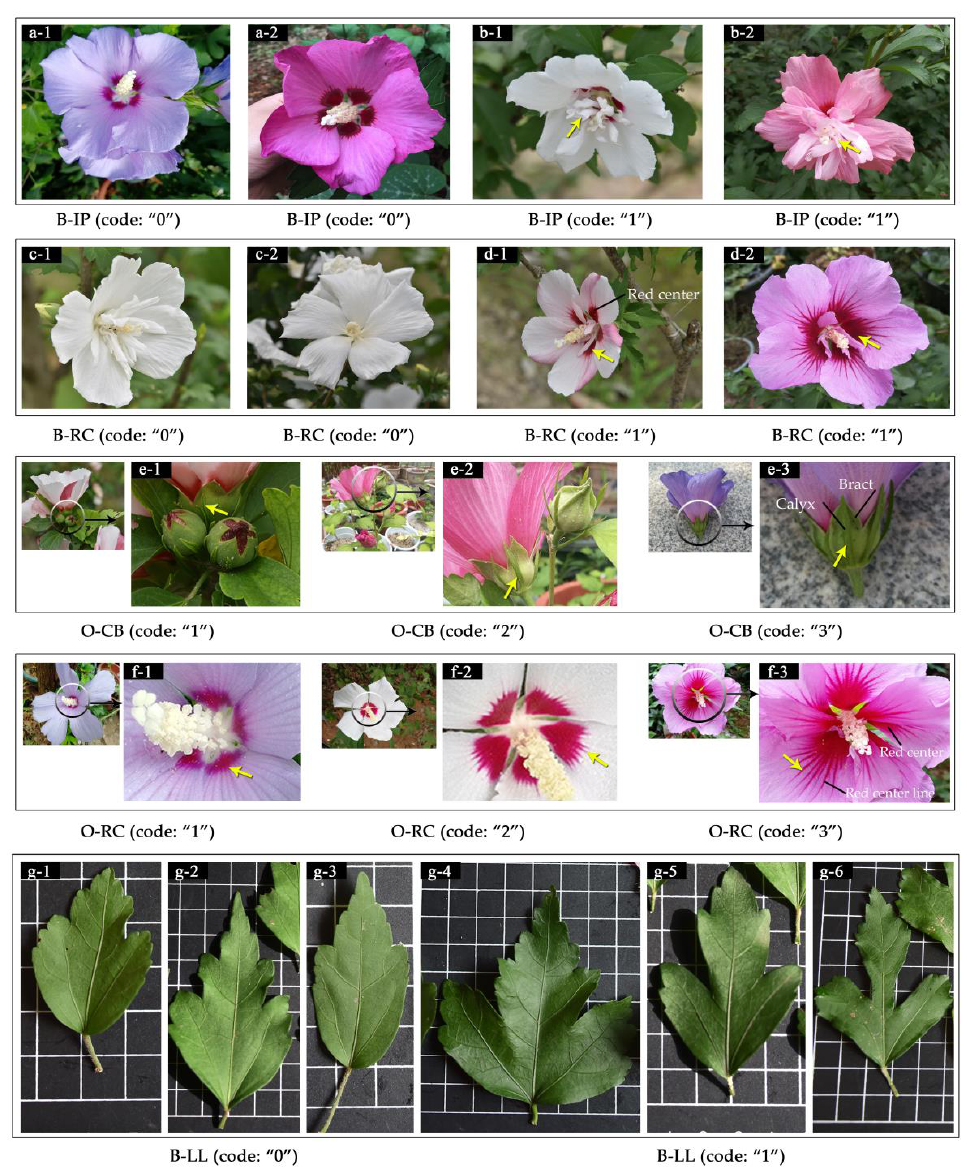
Figure 1. The description and codes for five qualitative traits of Hibiscus syriacus flower and leaf parts, for which the yellow arrow indicates the typical characteristic. Whether the stamens are heterogeneous in terms of inner petals (B-IP): ( a - 1 , a - 2 ) stamens not differentiated into inner petals (No, 0); ( b - 1 , b - 2 ) stamens differentiated into inner petals (Yes, 0). Whether the petals have the red center (B-RC): ( c - 1 , c - 2 ) petals without the red center (No, 0); ( d - 1 , d - 2 ) petals with the red center (Yes, 0). Relationship of the calyx with the bract (O-CB): ( e - 1 ) calyx shorter than bract (Shorter, 1); ( e - 2 ) calyx almost equal to bract (Near equal length, 2); ( e - 3 ) calyx longer than bract (Beyond, 3). Relationship of the red center line with the red center (O-RC): ( f - 1 ) red center line is almost equal to red center (Near equal length, 1); ( f - 2 ) red center line is longer than red center (Beyond, 2); ( f - 3 ) red center line is significantly longer than red center (Beyond obviously, 3). Whether leaf lobing is strong (B-LL): ( g - 1 , g - 2 , g - 3 ) low degree of leaf lobing (No, 0); ( g - 4 , g - 5 , g - 6 ) high degree of leaf lobing (Yes,